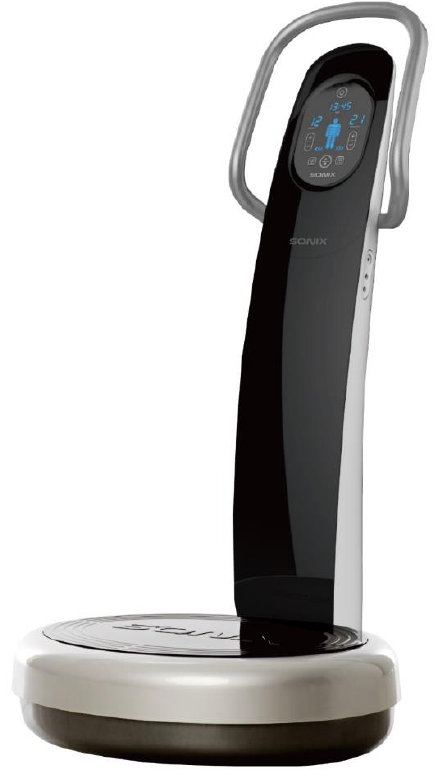
Figure 1. Figure 1. SW-VC15™.